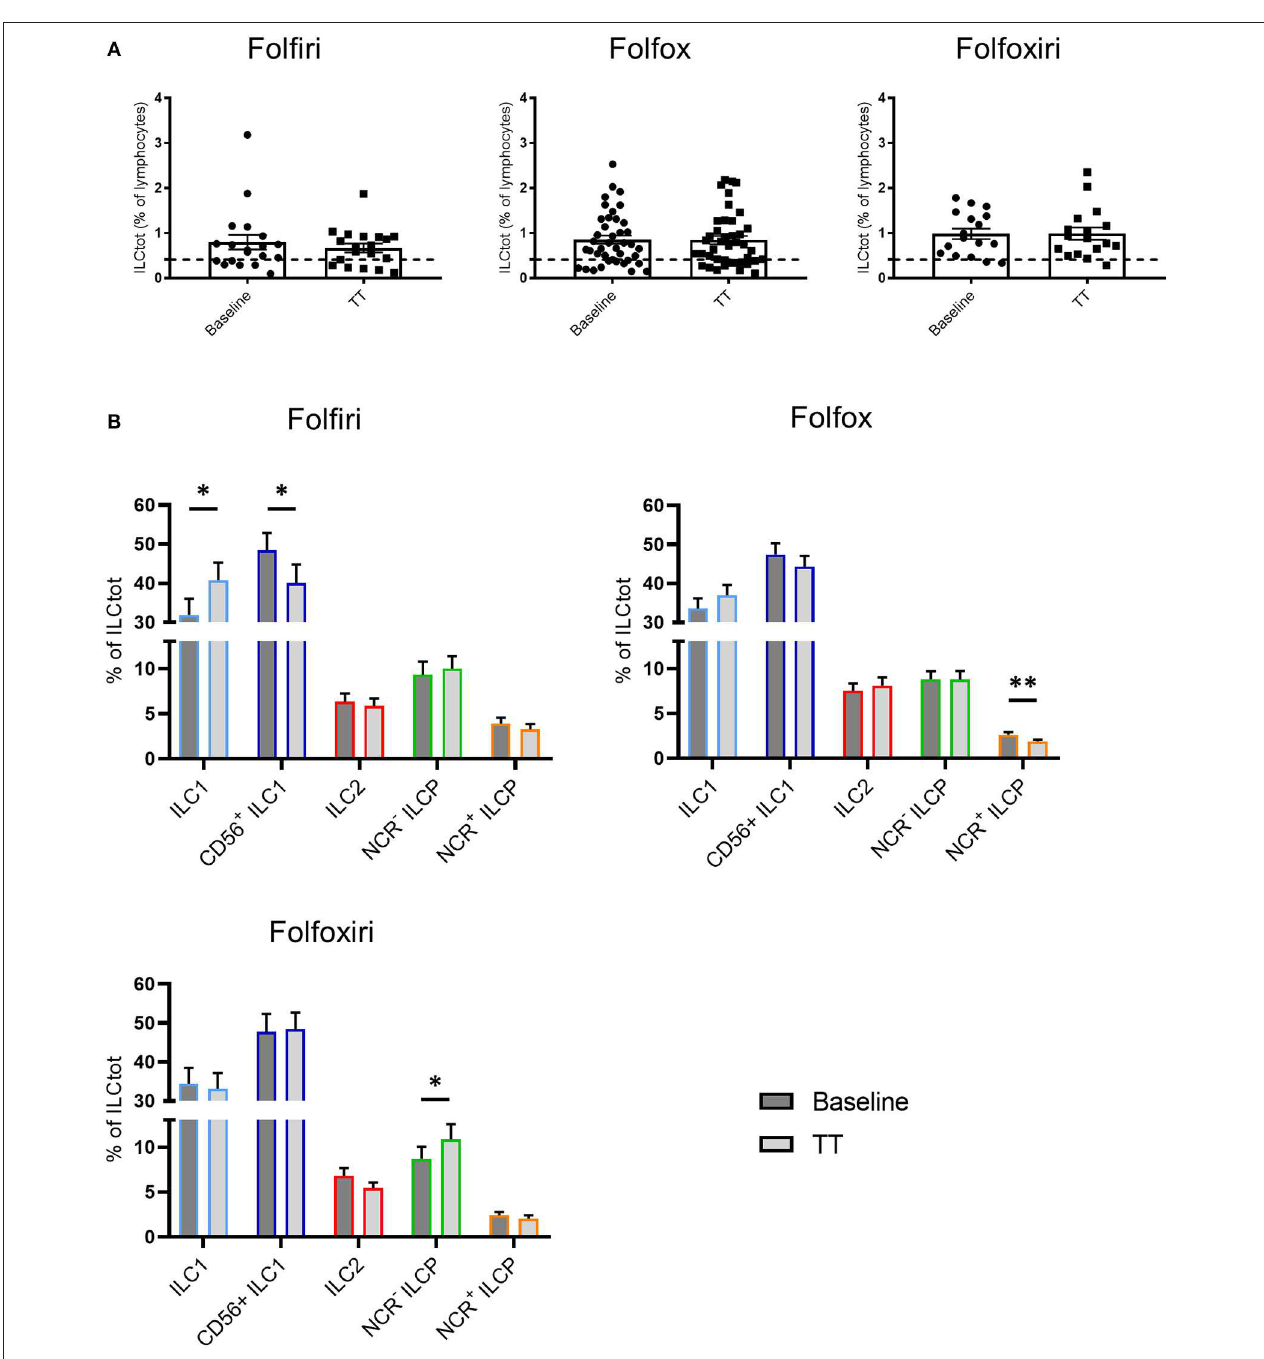
FIGURE 4 | Effect of chemotherapy treatments on ILC distribution. Frequencies of ILCtot (A) and ILC subsets (B) were analyzed by flow cytometry in PBMCs from chemotherapy-naïve mCRC patients (baseline) and after 3 months of treatment (TT). The mean frequency of ILCtot for HD is represented by a dashed line. Each patient received either the 5FU/Irinotecan regimen (Folfiri) (baseline/TT matched patients, n = 19), the 5FU/Oxaliplatin regimen (Folfox) (baseline/TT matched patients, n = 40), or the 5FU/Oxaliplatin/Irinotecan regimen (Folfoxiri) (baseline/TT matched patients n = 17). * p < 0.05, ** p < 0.005, as determined by Student’s t -test.